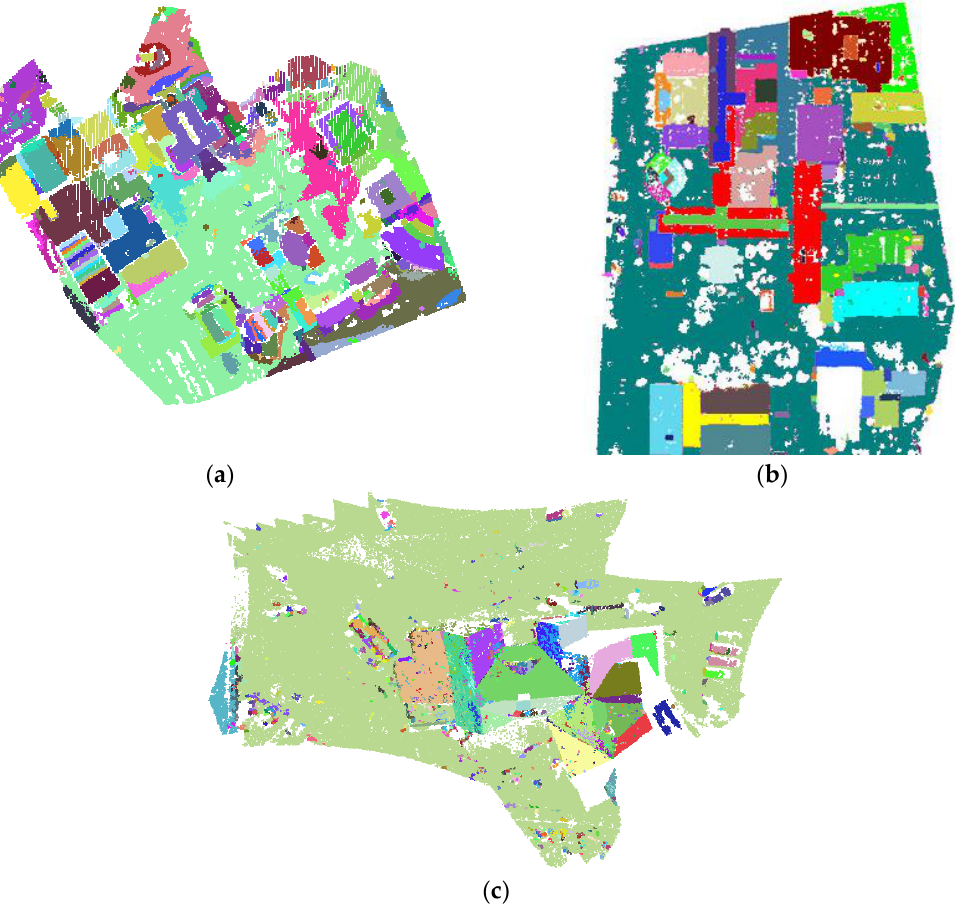
Figure 27. Planar surface extraction results for the ( a ) first; ( b ) second; and ( c ) third laser scanning datasets before quality control procedure